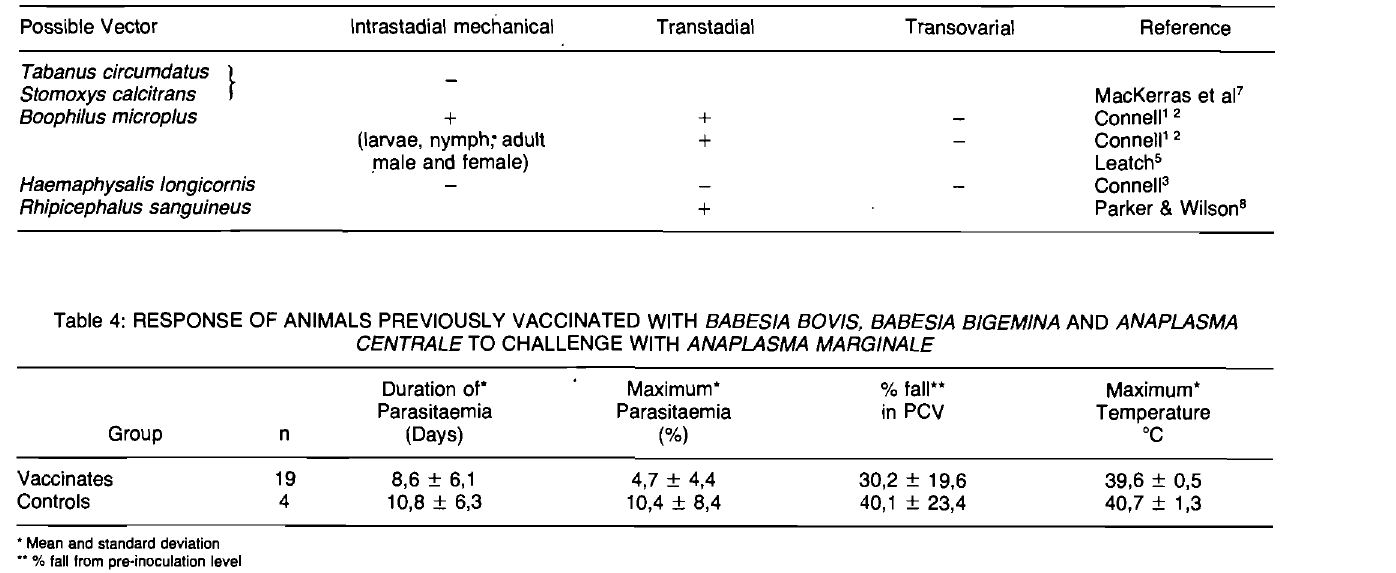
Table 3: TRANSMISSION OF ANAPLASMA MARGINALE IN QUEENSLAND